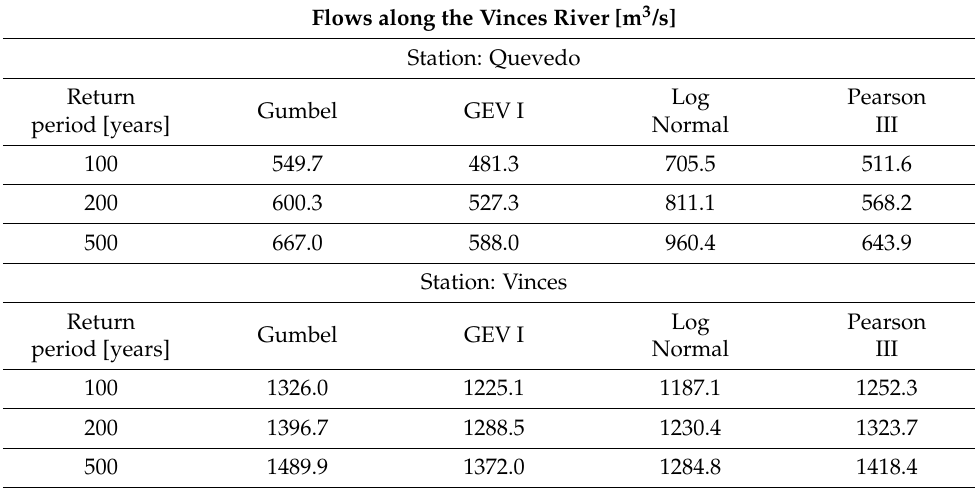
Table 2. Flows obtained by probabilistic methods.